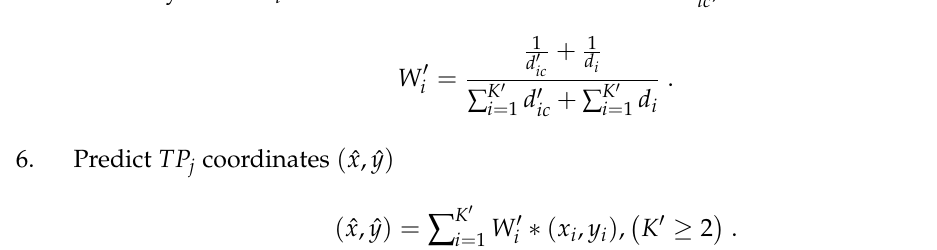
Figure 5 is the flow chart of the improved WKNN fingerprint positioning algorithm.